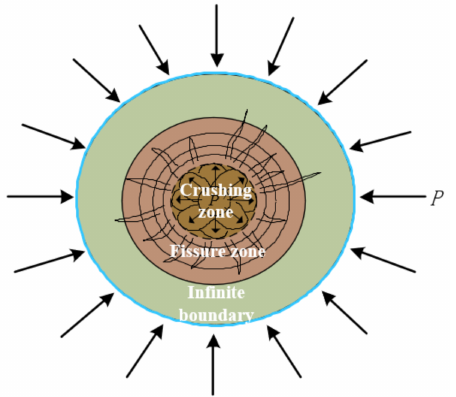
Figure 11. Schematic of blasting